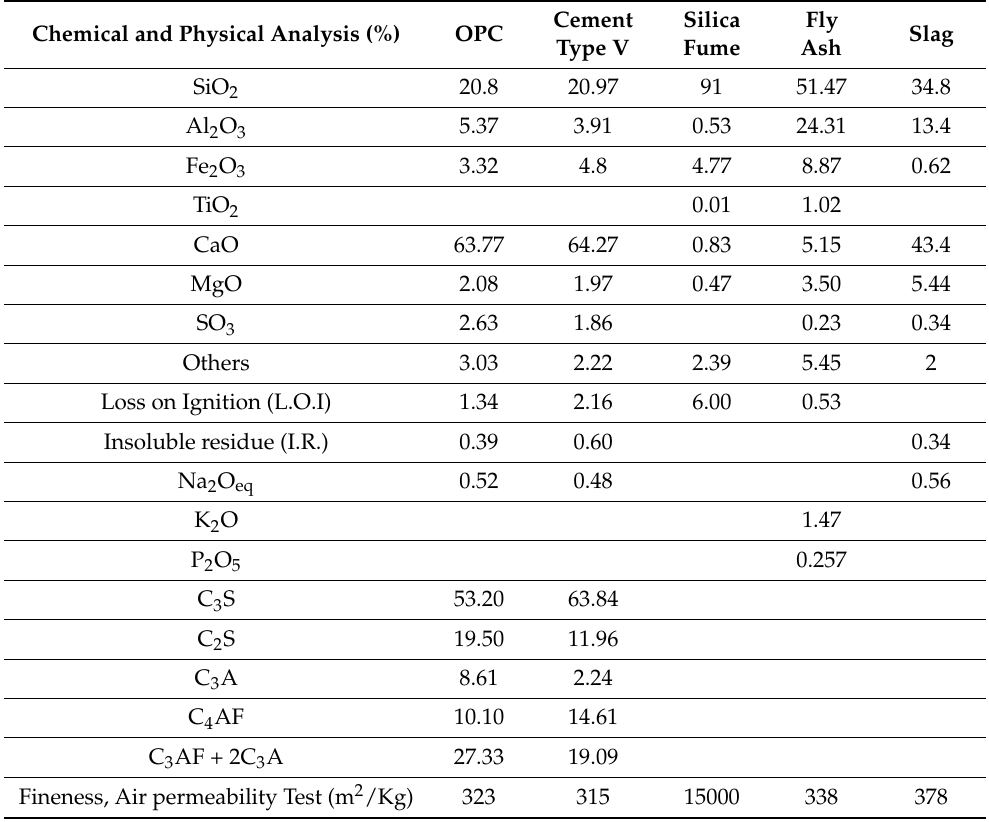
Table 1. Chemical and physical properties of